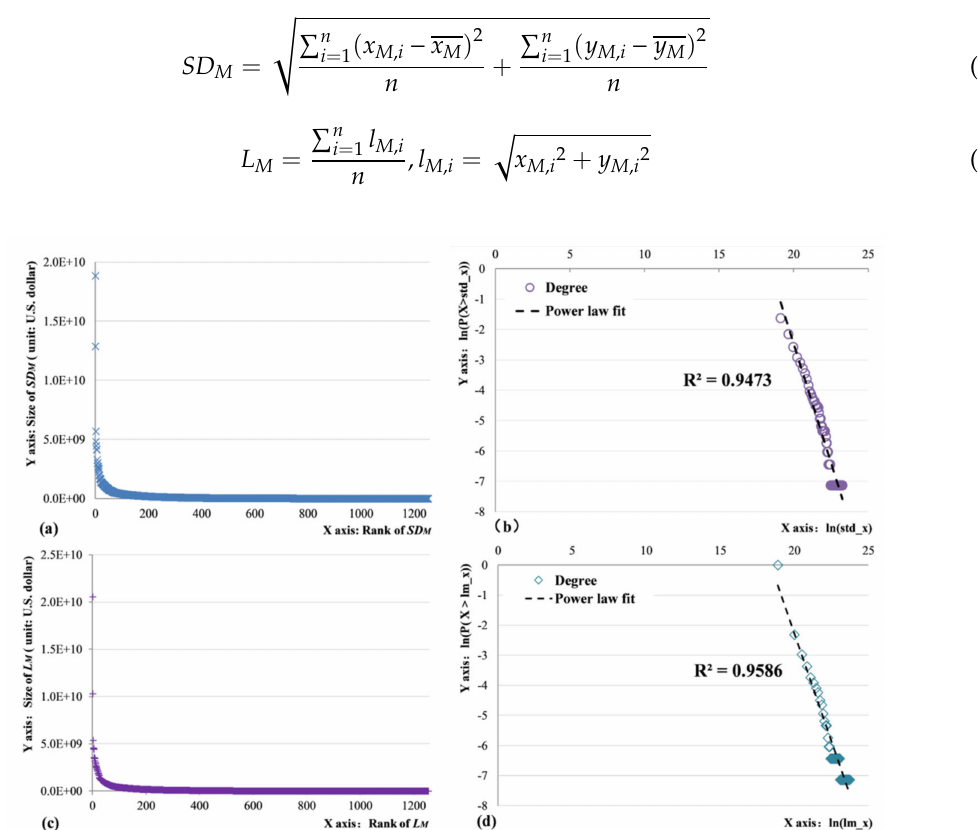
Figure 2. Heavy-tailed distributions of SD M and L M . ( a ) Rank–size distribution of SD M . ( b ) Probability density distribution (Log) of SD M . ( c ) Rank–size distribution of L M . (d) Probability density distribution (Log) of L M